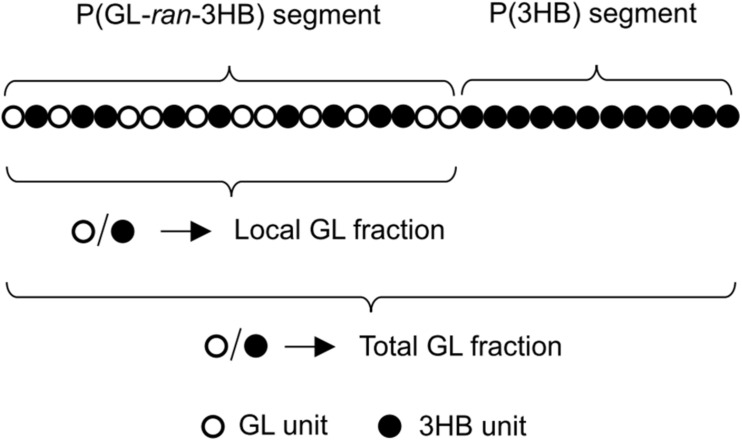
The proposed random-homo block monomer sequence of P(GL-co-3HB) synthesized by PhaCAR.